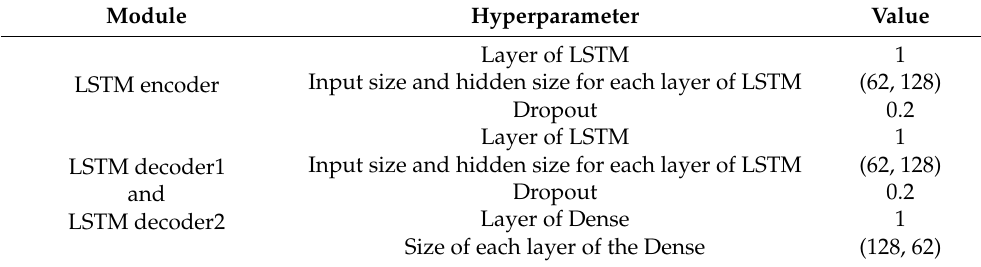
Figure 4. Proposed model architecture. The proposed model consists of three modules: an encoder network LE , and two decoder networks 𝐿𝐷 1 and 𝐿𝐷 2 . Table 4. Model hyperparameters.